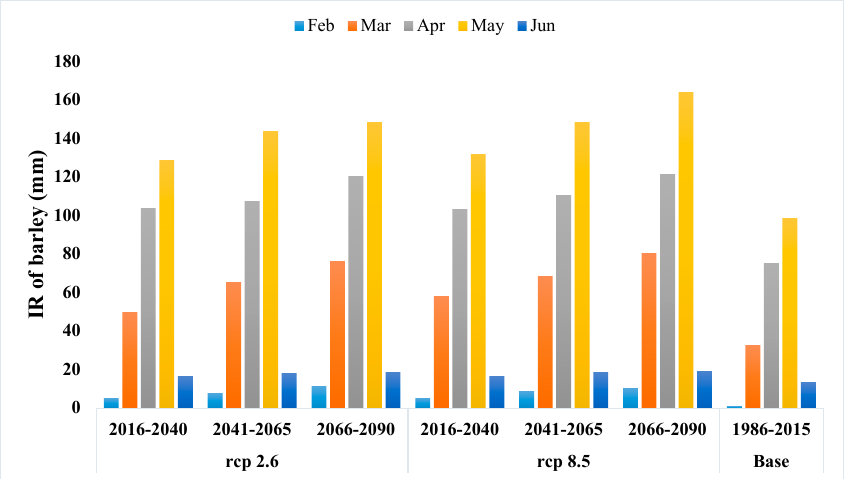
Figure 4. Comparison of the irrigation water requirement (IR) of winter wheat under scenarios rcp2.6 and rcp8.5 for the periods 2016–2040, 2041–2065, and 2066–2090 with the baseline period.